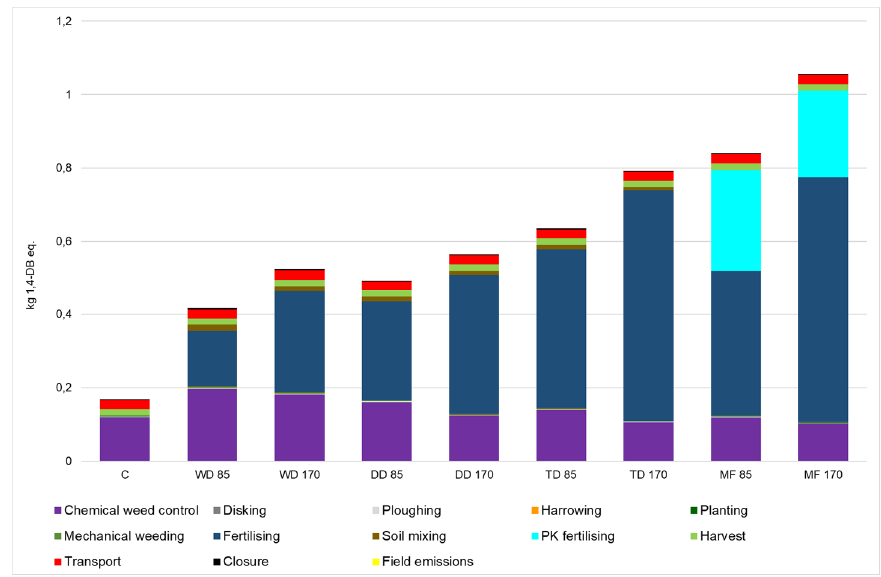
Figure 9. Freshwater ecotoxicity per 1 Mg d.m. of miscanthus in different fertilisation treatments.